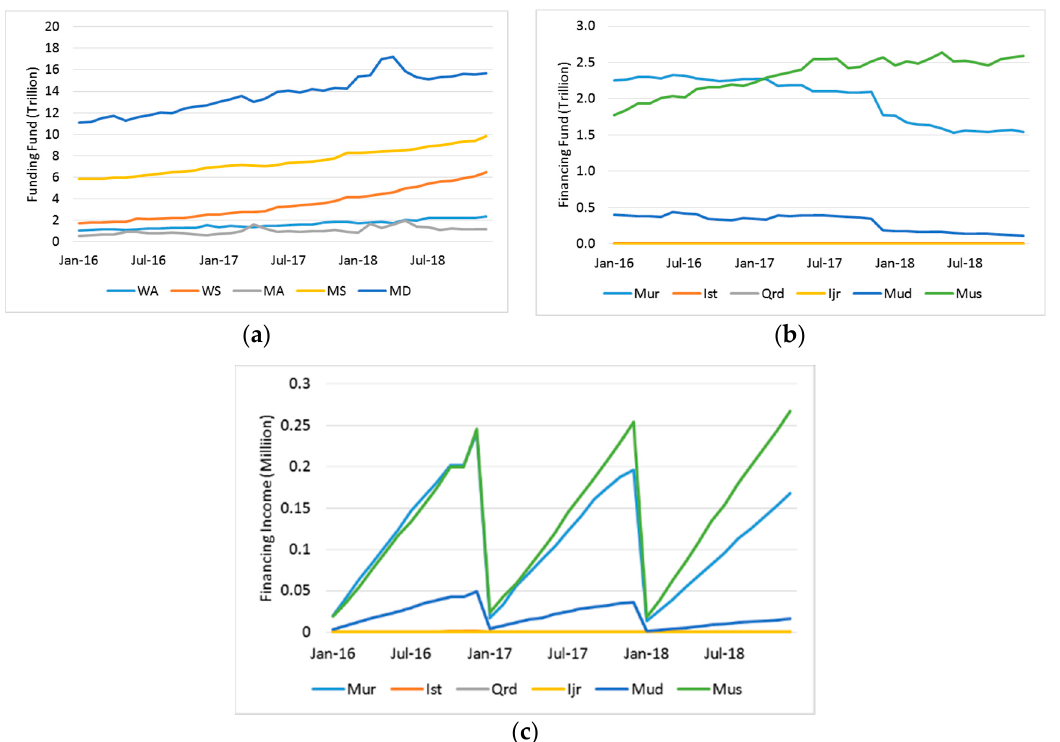
Figure A2. ( a ) Funding fund, ( b ) Financing fund, ( c ) Financing income from Bank B.